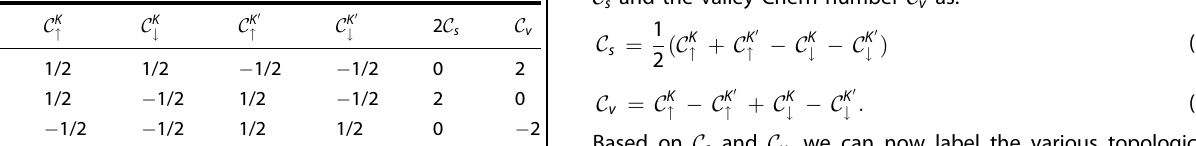
Table 2. Chern numbers ( C η ) corresponding to the spin ( s ) and valley s ( η ) degrees of freedom, along with the spin ( C s ) and valley ( C v ) Chern numbers, for the QSH, QVH-I, and QVH-II phases 41,42,45,46,56,57